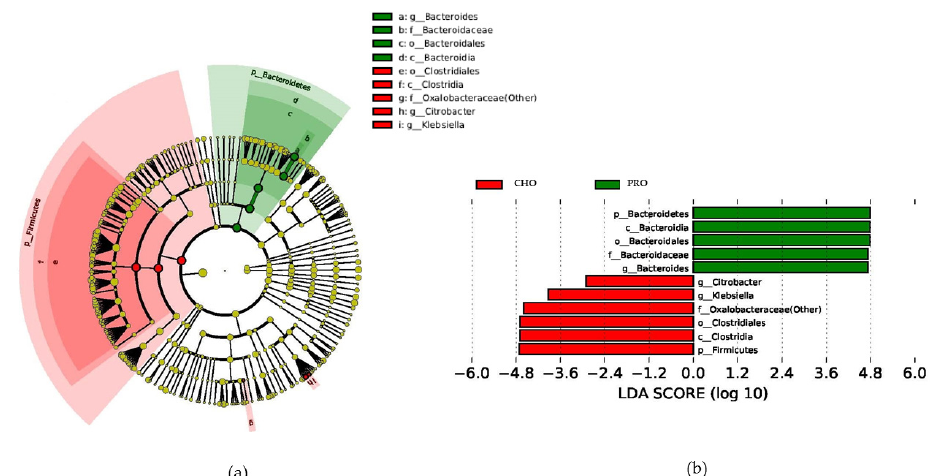
Figure 2. Cladogram and LDA score generated by LEfSe indicating differences in bacterial taxa between CHO and PRO groups after 10 weeks of supplementation. ( a ) Cladogram representing taxa enriched in PRO (green) and CHO (red) groups. ( b ) CHO and PRO LDA score; only the taxa meeting a significant LDA threshold value of >2 are shown. The CHO ‐ enriched taxa are indicated in red (negative score), whereas the PRO ‐ enriched taxa are indicated in green (positive LDA score).